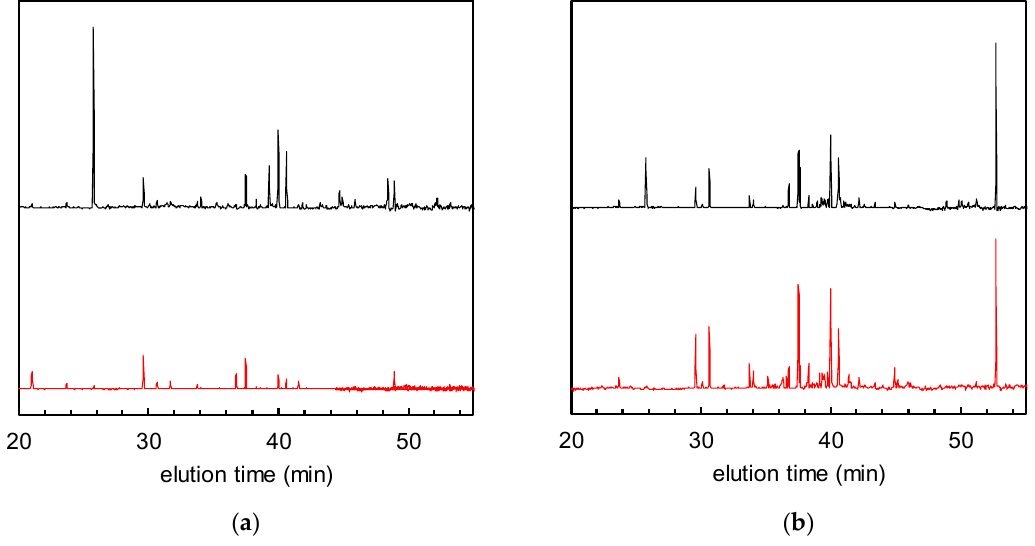
Figure 2. Gas chromatograms of solid phase ‐ extracted odour components after tobacco smoke adsorption (= 0 h of UV irradiation, black) and after 24 h of UV irradiation (red). ( a ) Non ‐ woven fabric with TiO 2 ; ( b ) non ‐ woven fabric without TiO 2 .